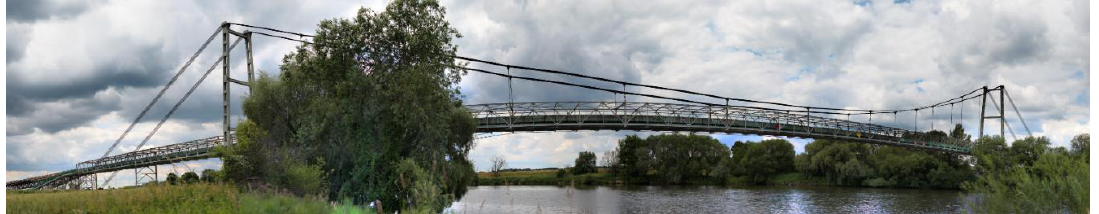
Figure 1. Side view of the bridge from the upper water side.